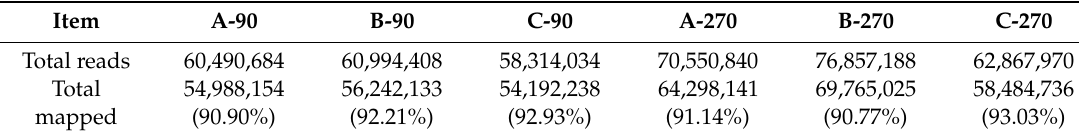
Table 4. Statistics of total reads and mapped